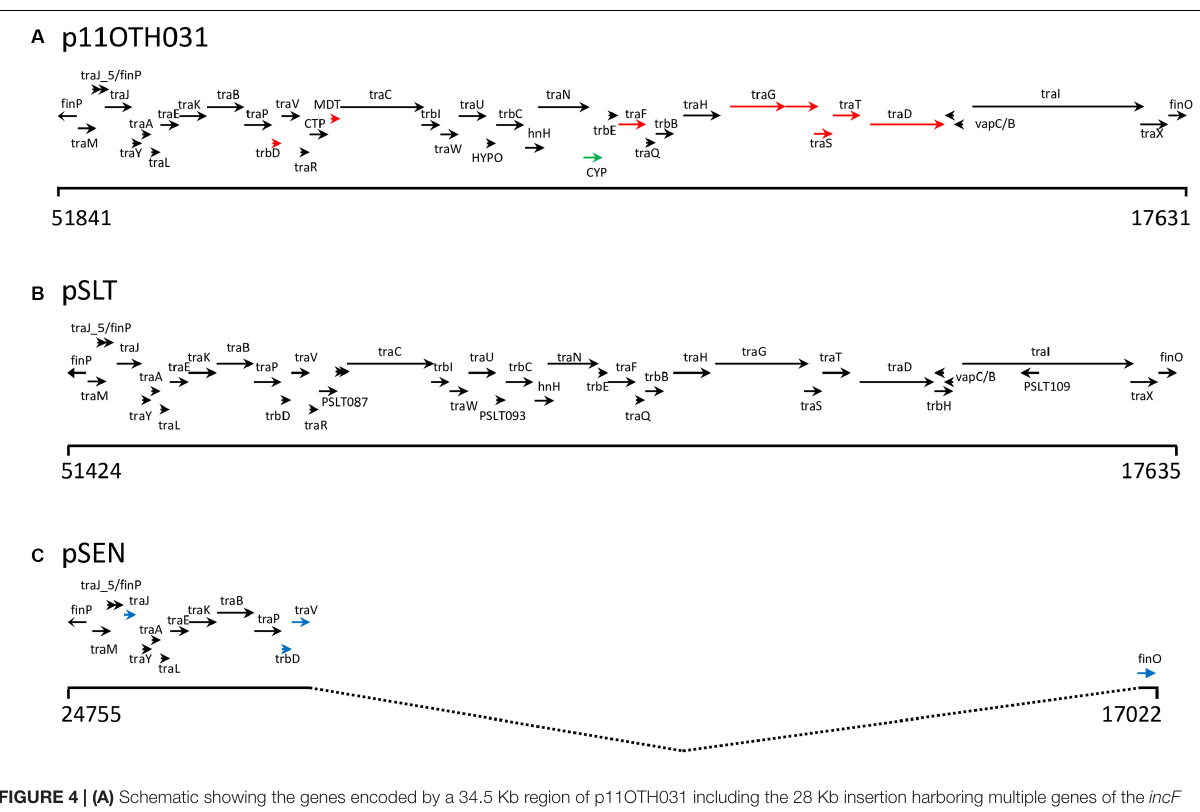
our Canadian isolates to generate a ML phylogeny based upon 906 SNPs identified by a SNVPhyl analysis ( Figure 6